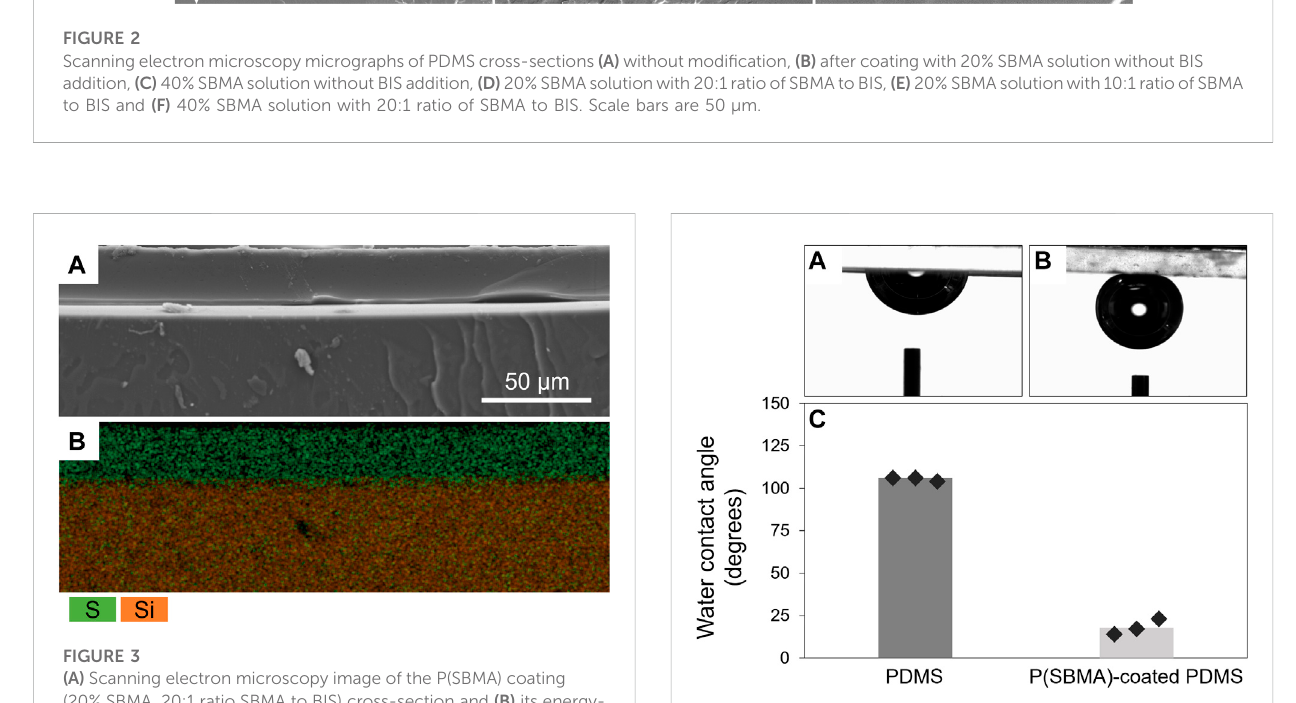
FIGURE 4 (A,B) Representativeimages ofcaptive air bubble measurements for PDMS and P(SBMA)-coated PDMS, respectively. (C) Calculated water contact angles from the measured captive air bubbles in panel (A, B) for non-coated and P(SBMA)-coated PDMS samples. Markers represent the average value for each measured